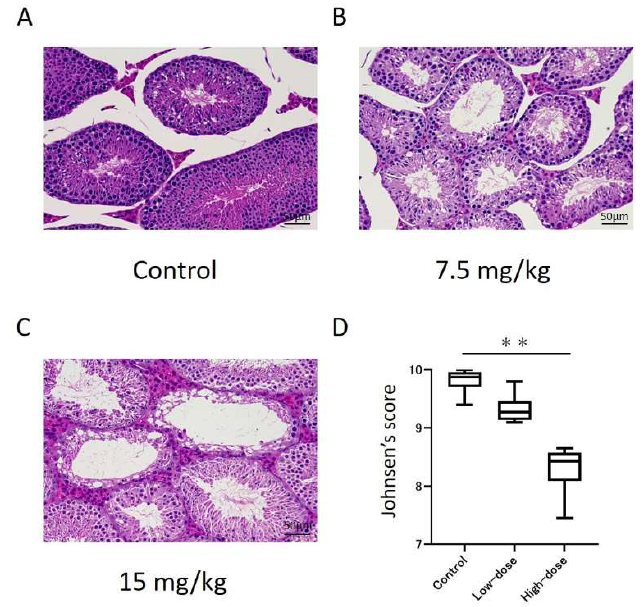
Figure 5. Histopathological changes in the testes of the control and cisplatin-treated mice. ( A – C ) Images of hematoxylin and eosin staining of the seminiferous tubules. ( D ) Graphical representation of the Johnsen score. ** p < 0.001.